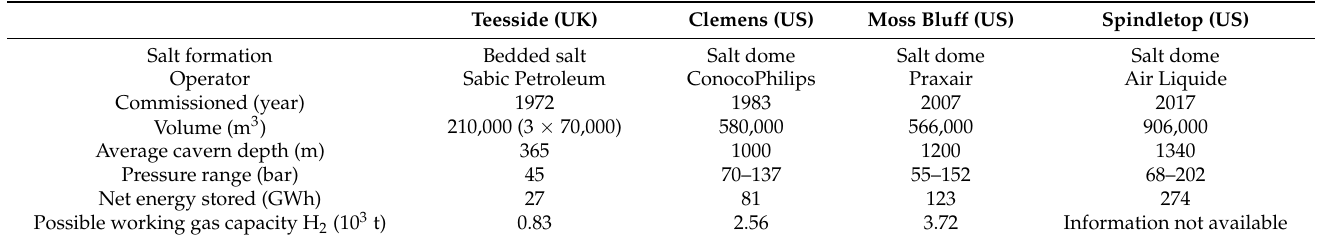
Table 3. Information about existing hydrogen storage salt caverns in the United Kingdom and the United